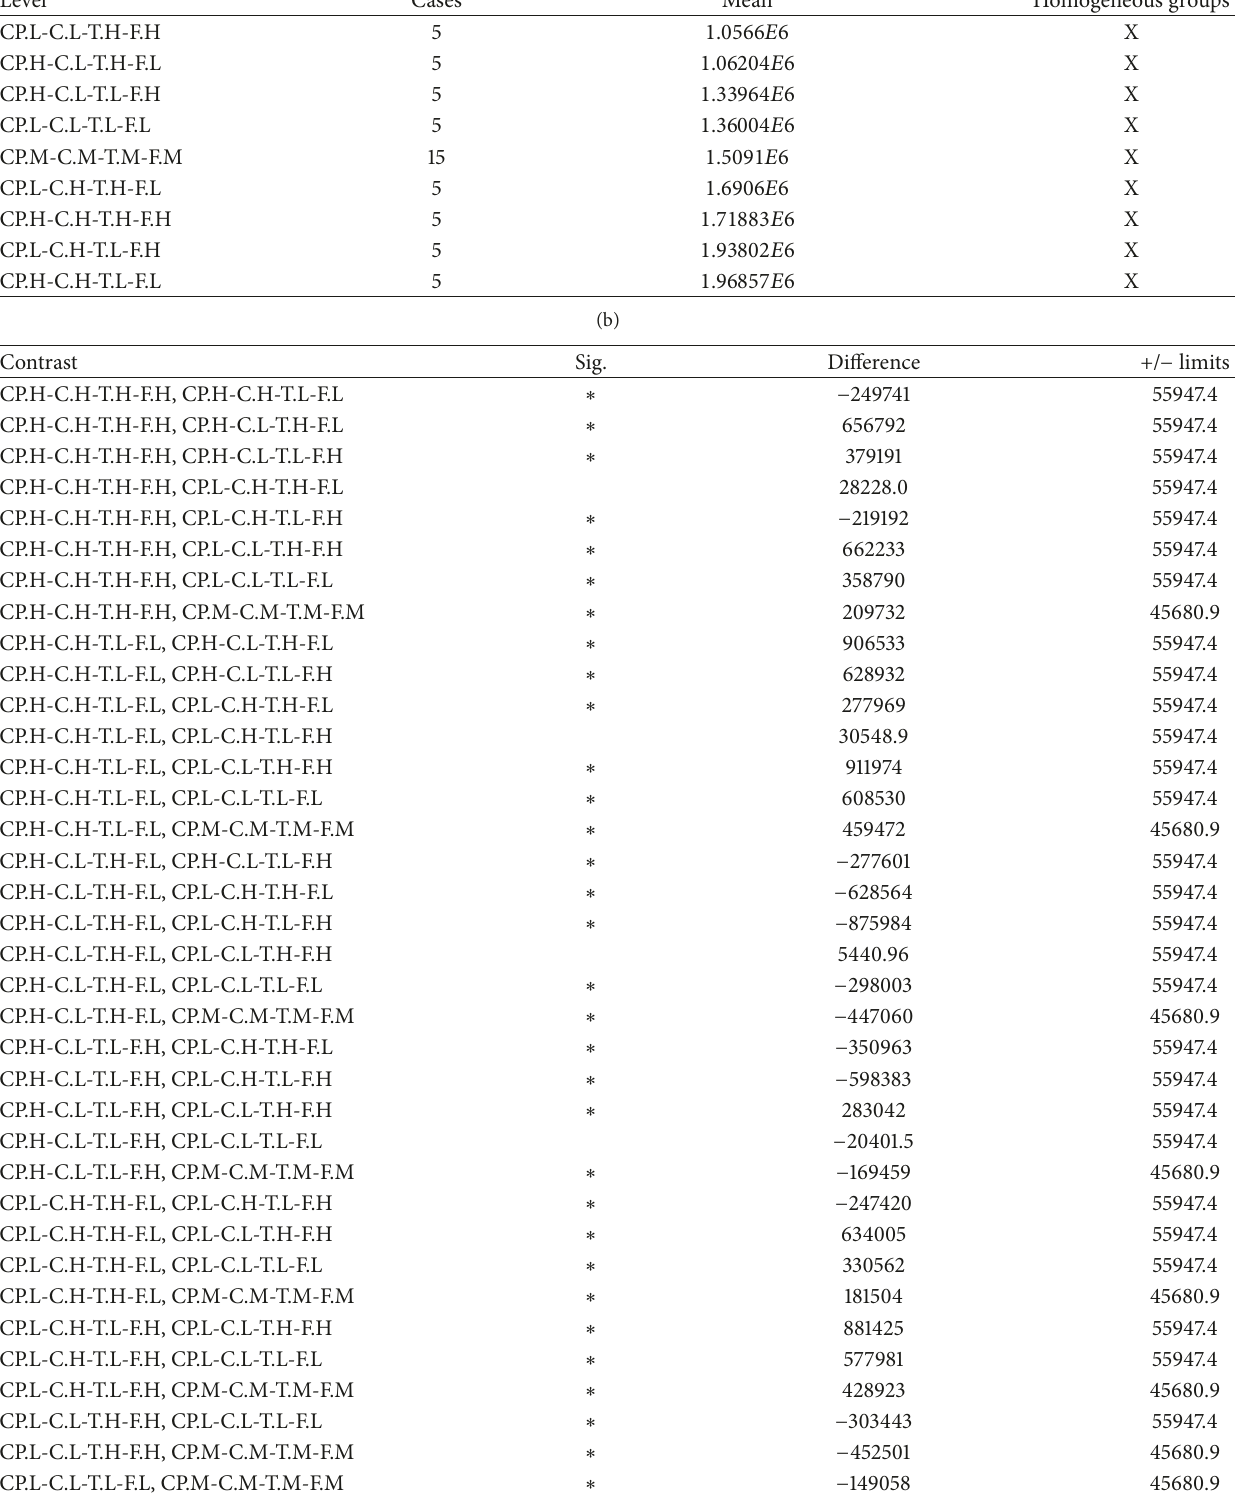
Table 5: Multiple ranges testing for scenario